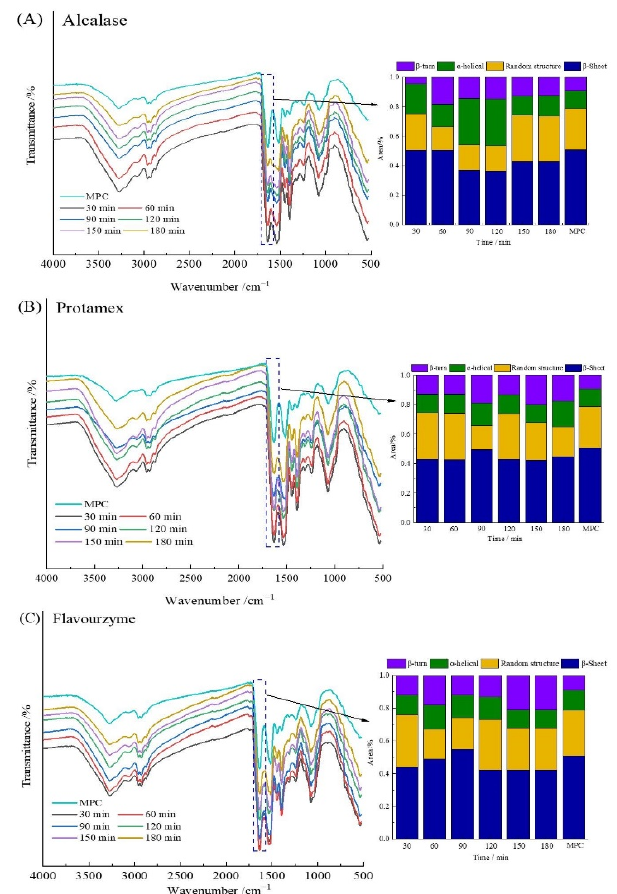
Figure 4. Structural characterization of MPC and hydrolysates. FTIR spectra and relative content of the secondary structure of MPC and hydrolysates prepared with: Alcalase ( A ); Protamex ( B ); and Flavorzyme ( C ).